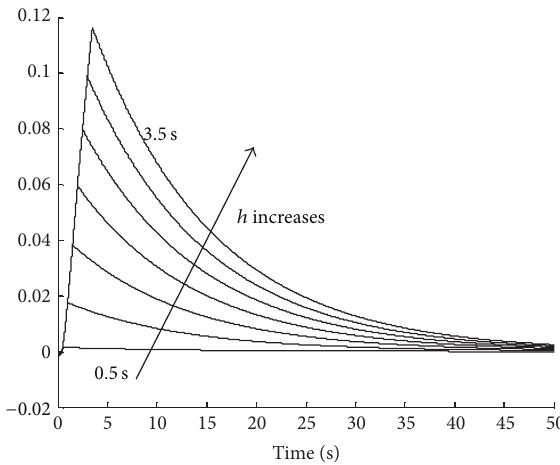
Figure 6: Effect of the variation of the sampling time, ℎ , in the error of the second state variable, 𝑥 2 (𝑡)